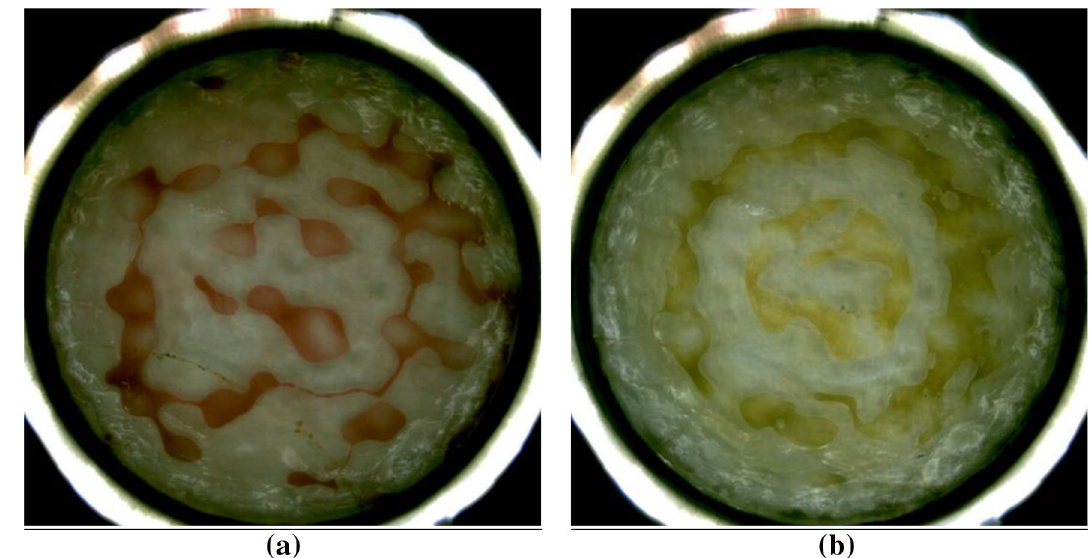
Fig. 7 Freeze image for the flow at 40 rpm and a filling level of 30%: a of the emulsion with 90% H